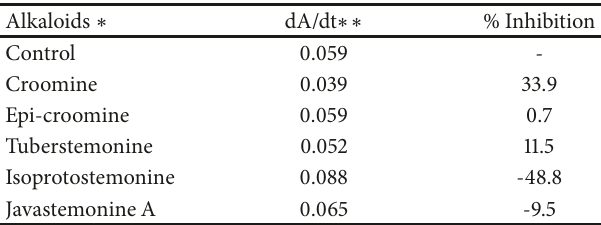
Figure 2: Selected cluster sphere of the receptor as the representa- tion of the binding site is inside the grid box. Table 1: Inhibition (%) of NADPH-dependent catalytic activity of PfFNR